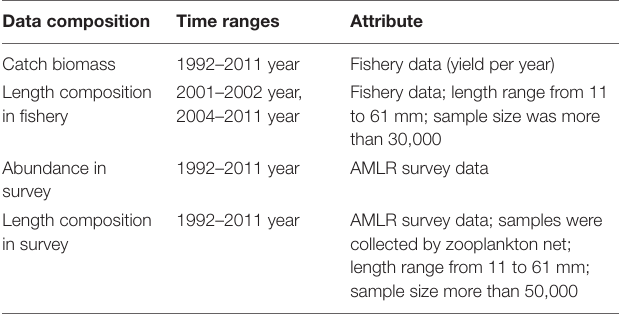
TABLE 1 | Data composition for model